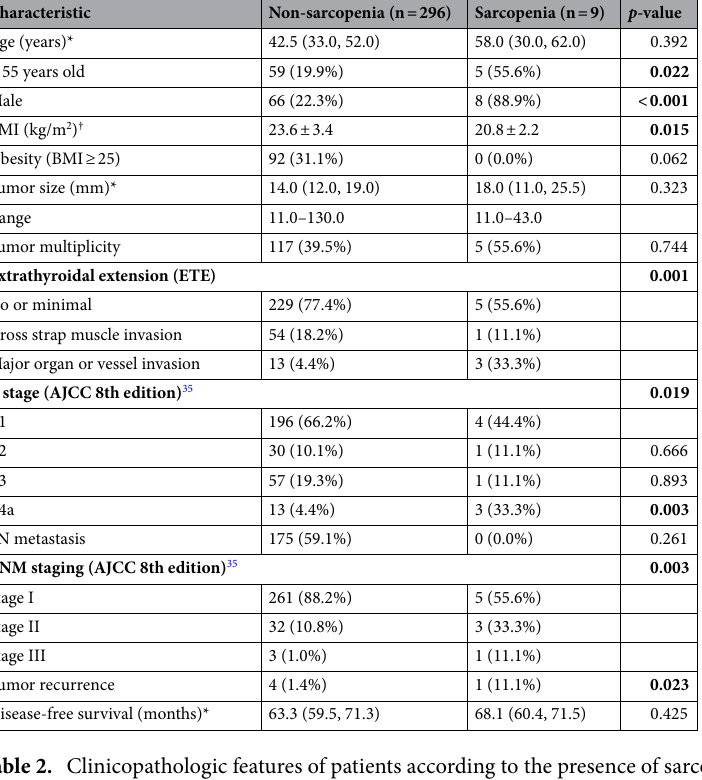
Table 2. Clinicopathologic features of patients according to the presence of sarcopenia. Significant values are in bold. Data are presented as number of patients (percent) unless otherwise specified. *Data are presented as median (1st quartile, 3rd quartile). † Data are presented as mean ± standard deviation. BMI, body mass index; AJCC , American Joint Committee on Cancer; LN , lymph node.